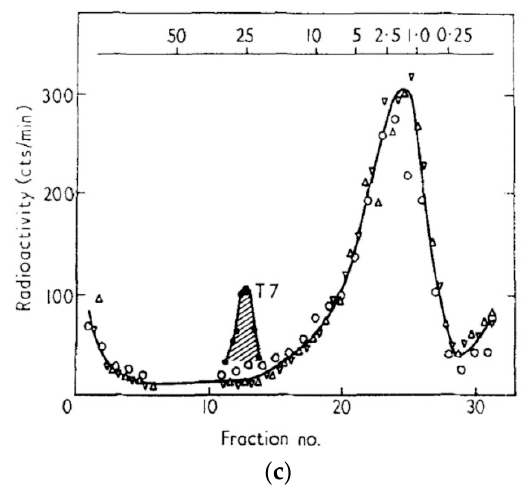
Figure 5. Host DNA breakdown and reincorporation into phage DNA during exponential phase T4 Infection. The top X axis of each figure indicates approximate molecular weight in megadaltons: ( a ) Status of 3 HdT-labeled host DNA at various times during infection of E. coli B with T4D or T4 amN55x5 (dCMP HMase). The infection was carried out in exponential phase at 37 °C in glycerol-casamino acids (GCA) medium. Both T4 am4332 (DNA polymerase) and T4 amN55 (HMase) mutants produce no phage DNA and thus no phage when grown on a non-amber-suppressor strain such as E. coli B or ZK126; ( b ) Sucrose gradient analysis was used to determine the size of the acid-insoluble fraction of the host DNA at various times after exponential phase infection of E. coli B by T4D. The left panel shows fractions collected from samples lysed at 6, 8, and 13.5 min, the right panel shows fractions collected from samples lysed at 13.5, 25, and 60 min. Here, “T4” and “T7” refer to the phage DNAs used as sedimentation markers; ( c ) Size of the host DNA 25 min after infection with a T4 mutant defective in the gene 46 and 47 encoded exonuclease; here, all of the host DNA is only degraded to approximately the size of T7 DNA, and no host label is incorporated into the phage DNA which is being produced [25].